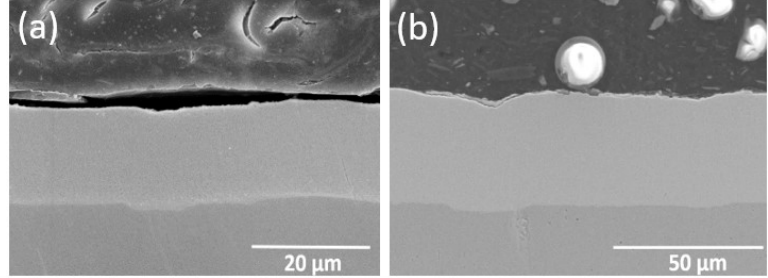
Figure 3. SEM images of coating cross-section: ( a ) Ni–P Coating; ( b ) Ni–Mo Coating.